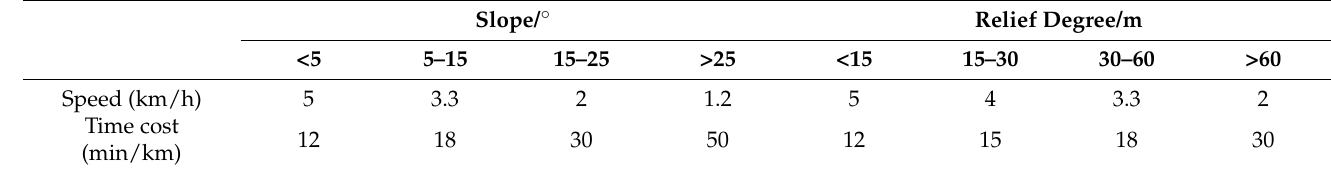
Table 3. Time cost values of different topographic